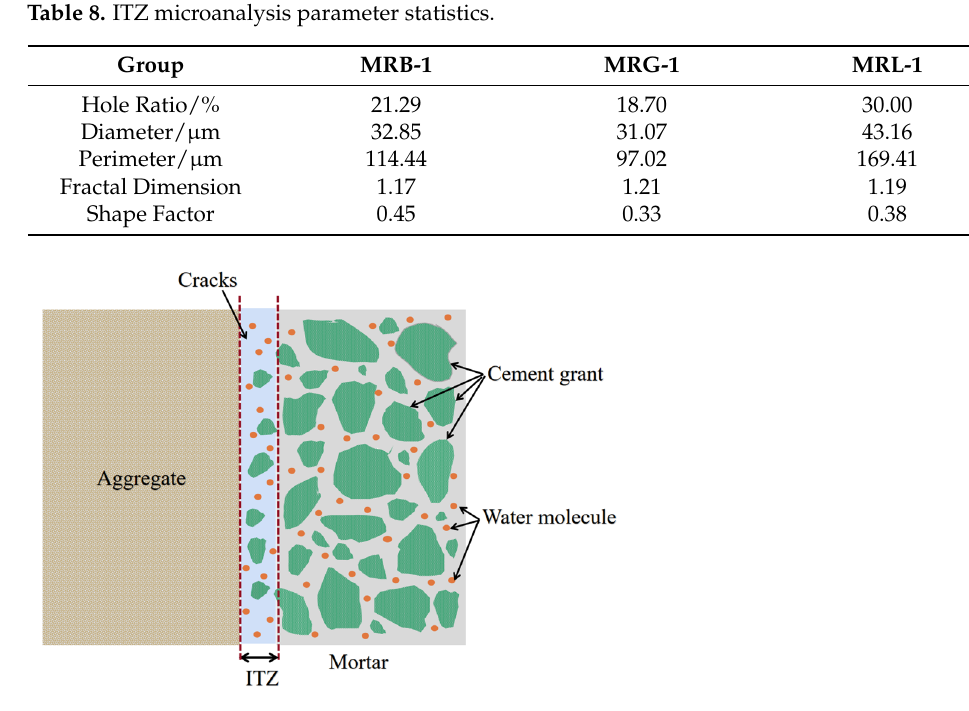
Figure 19. The failure mechanism of the mortar-rubble interfacial zone.